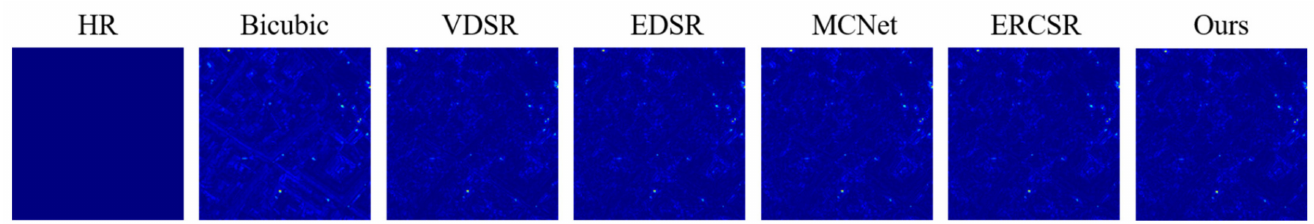
Figure 9. Absolute error map comparisons for test images in the Pavia Centre dataset of various algorithms with a scale factor of